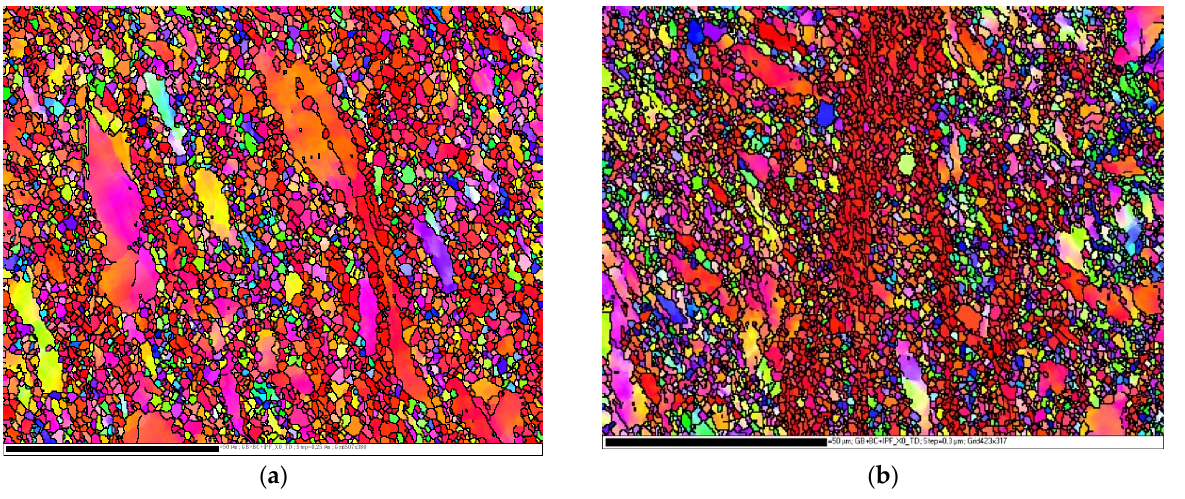
Figure 3. EBSD inverse pole figure (IPF) maps of the AA-Mg after ECAP process for two passes using ϕ = 90° and different routes, route A ( a ) and route C ( b ).